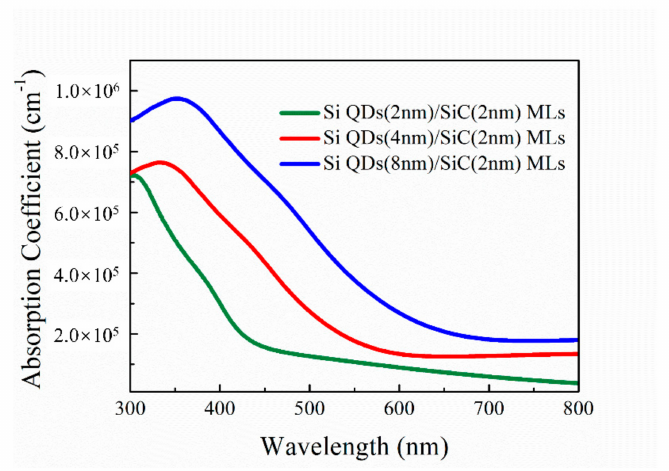
Figure 3. Spectra of optical absorption coe ffi cients of Si QDs / SiC